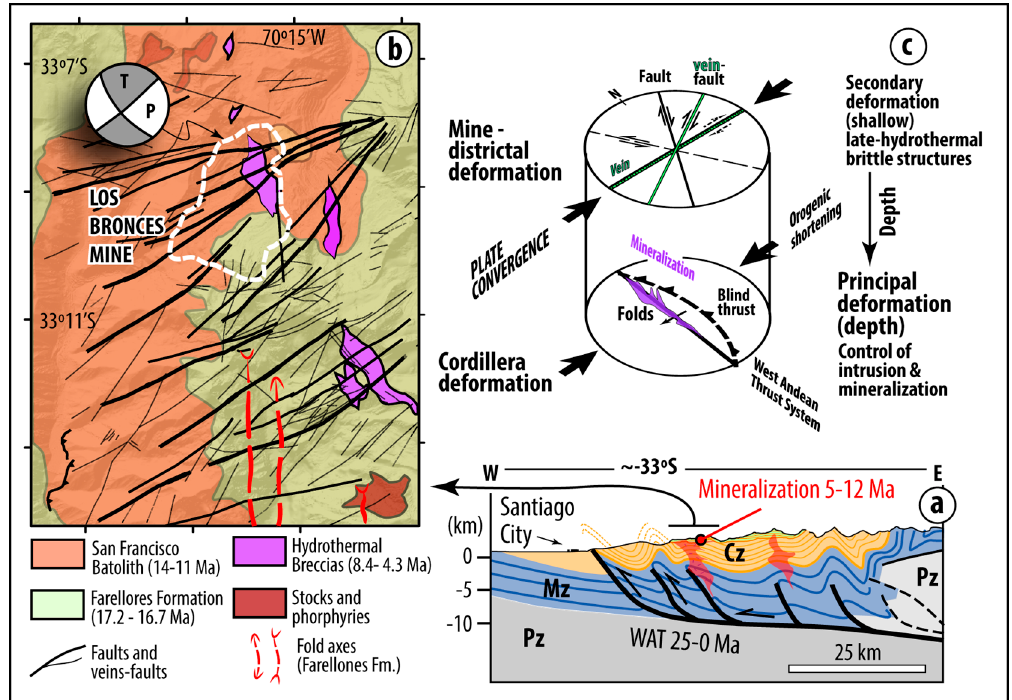
Figure 5. ( a ) A simplified east-west structural cross sections showing the tectonic context of the Rio Blanco-Los Bronces mining district (after Reference [32]). WAT: Western Andean Thrust, Pz: Paleozoic, Mz: Mesozoic, Cz: Cenozoic; ( b ) A simplified geological map of the Rio Blanco-Los Bronces district showing the main structural patterns and the mine-scale strain tensor (after Reference [28]); ( c ) Kinematic model showing the relationship between the different-scale structural patterns observed in the mining district. The model explains the kinematic relevance of the different structures under the plate convergence vector (after Reference [32]).